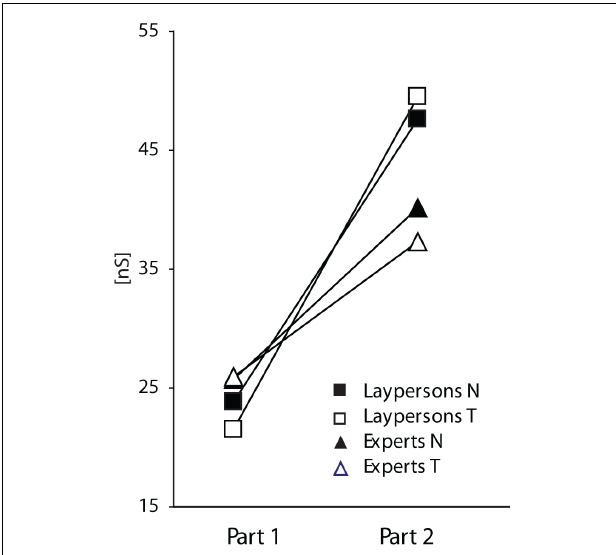
FIGURE 6 | Effect of the type of information given in Part II on the magnitude of the electrodermal reactivity (nS, nanoSiemens; N, neutral information;T, tabloid-type information).